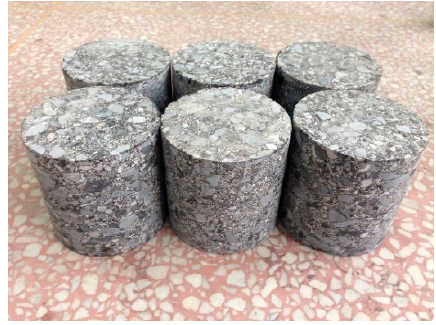
Figure 5. Specimen of AC-13C asphalt mixture.